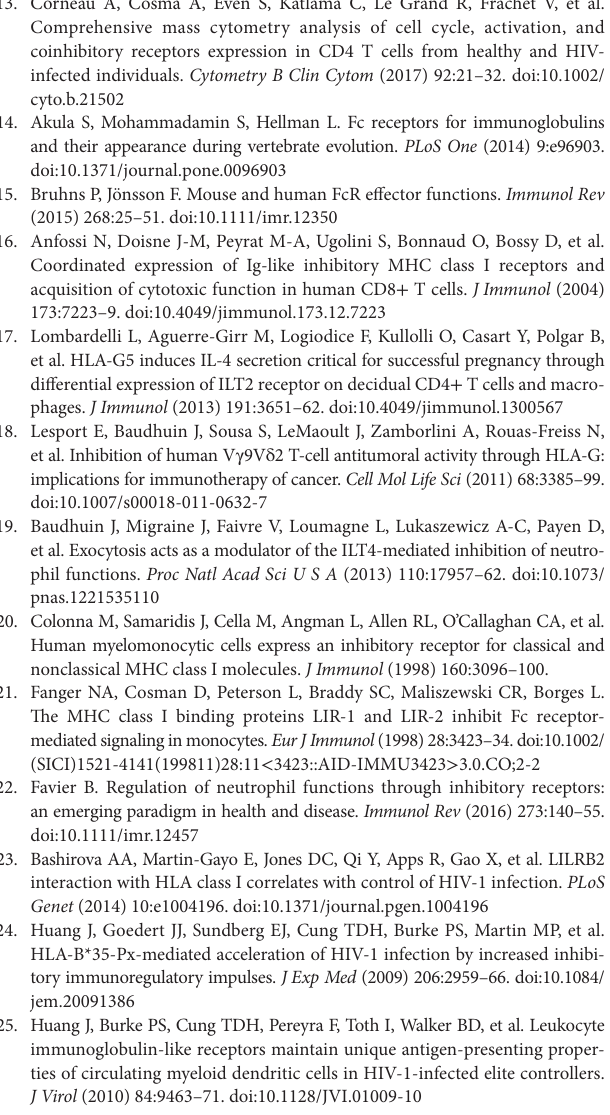
FigUre s7 | Correlation analysis of total CD32a + CD4 + T-cell cluster and cluster #5 cell abundances with HIV DNA levels. (a) Correlation analysis of total CD32a + CD4 + T-cell cluster cell abundances with total HIV DNA levels. The HIV DNA load (log 10 copies/10 6 PBMCs) for each sample are indicated on the X -axis, and the associated percentage of cells relative to CD4 + T cells for CD32a + CD4 + T-cell clusters on the Y -axis. The Pearson correlation coefficient was equal to 0.4329 ( p = 0.0727). (B) Correlation analysis between cluster #5 cell abundance and HIV DNA levels. For each sample, the HIV DNA load (log 10 copies/10 6 PBMCs) is indicated on the X -axis, and associated percentage of cells relative to CD32a + CD4 + T cells for cluster #5 on the Y -axis. The Pearson correlation coefficient was equal to 0.6902 ( p = 0.0015). FigUre s8 | Percentages of cells associated with clusters #5, #258, #136, #86, #261, #241, #162, #312, #243, #188, and #142 among CD4 + T cells in HIV-infected patients and healthy donors. (a–D) Graphs showing the cell abundance relative to that of CD4 + T cells for clusters previously shown to be differentially abundant between HIV-infected patients (primary HIV and HIV cART) and healthy donors (healthy) among CD32a + CD4 + T cells. (a,B) Clusters #5, #258, #136, #86, and #261 were significantly more abundant in Primary HIV (circle) and HIV cART (square) than Healthy (triangle) samples among CD32a + CD4 + T cells. Cluster #5 was also more abundant in primary HIV than in HIV